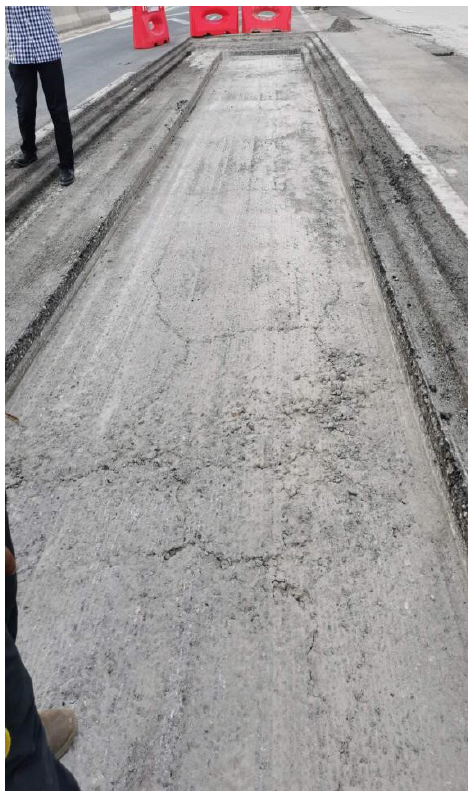
Fig. 4 Field excavation